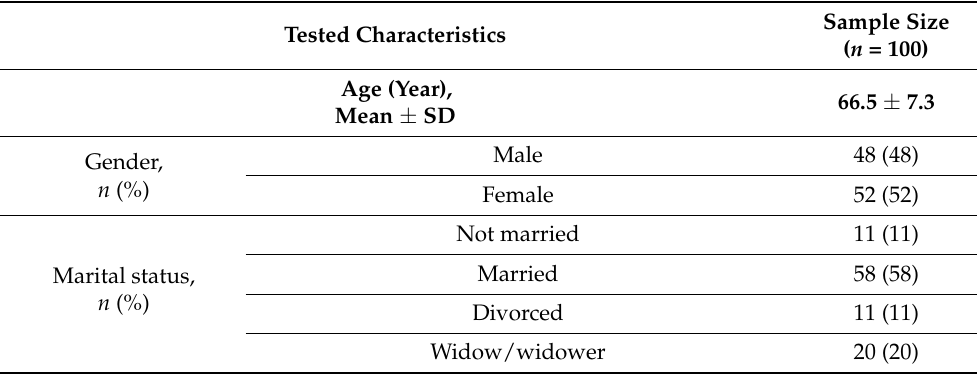
Table 1. Patient’s sociodemographic and clinical